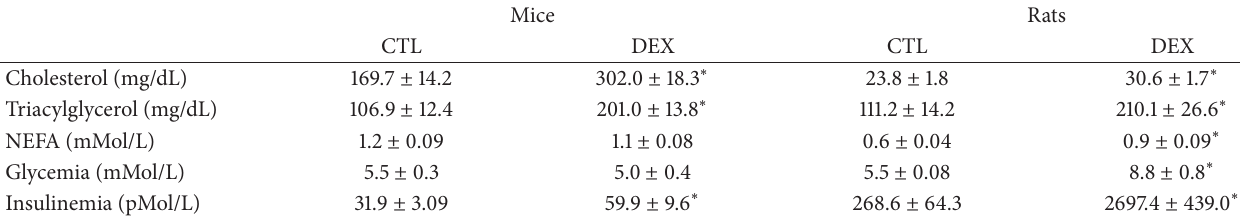
Table 2: Metabolic variables in 12 hour fasting DEX-treated mice and